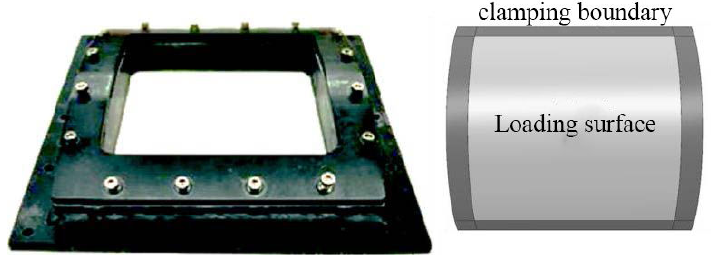
Figure 3. Simplified clamping device.